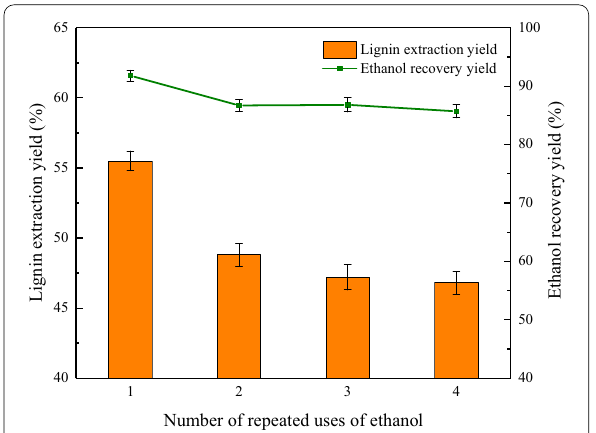
Fig. 7 Influence of solvent recycling on the lignin extraction rate and efficiency of ethanol recovery